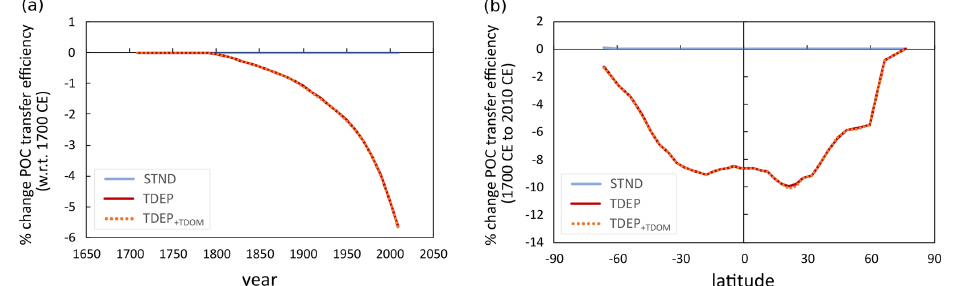
Figure 15. TDEP biological pump transfer efficiency (the proportion of POC exported at 80m that reaches 1040m; percent change with respect to 1700CE): (a) global mean change per year with respect to 1700 and (b) latitudinal change at the year 2010 with respect to 1700. STND is the standard model, and TDEP is the temperature-dependent model, TDEP + TDOM is temperature-dependent POM and DOM and is described in Sect.